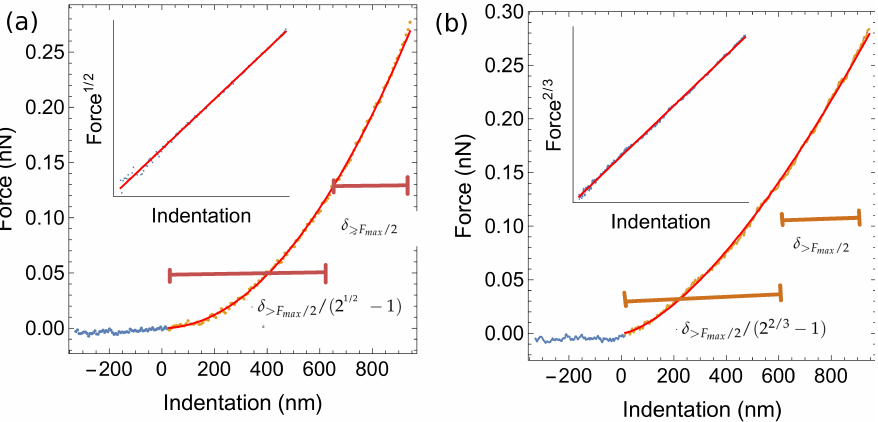
Figure 3. Force as a function of the indentation for ( a ) the pyramidal tip test, and ( b ) for the spherical bead test. The inset shows the force to the power of 1/2 ( a ) or 2/3 ( b ) as a function of indentation and the least squares fit to the data for the pyramidal tip ( a ) and conical tip ( b )